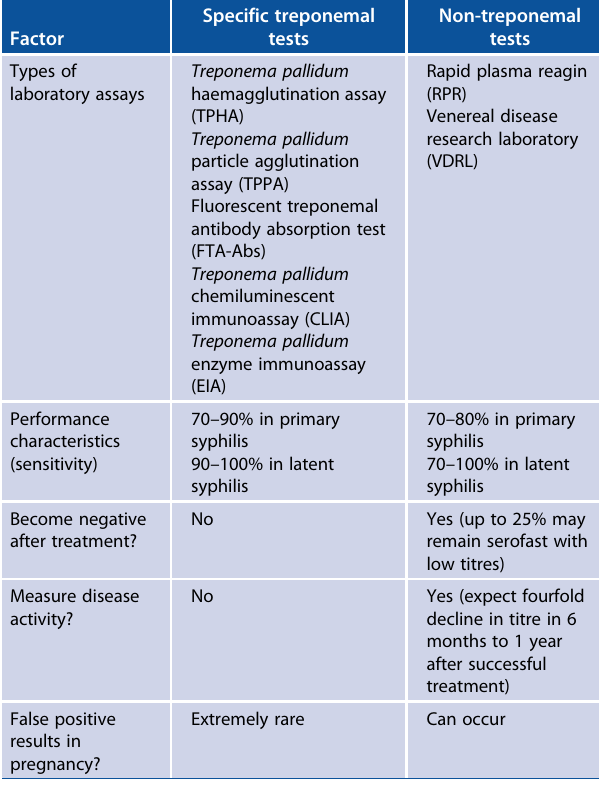
Specific treponemal tests Treponema pallidum haemagglutination assay (TPHA) Treponema pallidum particle agglutination assay (TPPA) Fluorescent treponemal antibody absorption test (FTA-Abs) Treponema pallidum chemiluminescent immunoassay (CLIA) Treponema pallidum enzyme immunoassay (EIA)